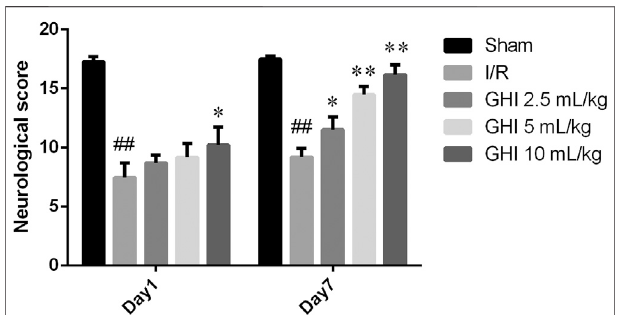
FIGURE 1 | Effect of GHI on neurological de fi cit scores in focal cerebral I/R rats. Groups were as follows: Sham group (Sham), ischemia-reperfusion group(I/Rgroup),GHI2.5 ml/kggroup,GHI5 ml/kggroup,andGHI10 ml/kg group at 1 and 7 days, respectively. Values were expressed as mean ± SD (n (cid:2) 8). ## p < 0.01 vs. the Sham group, * p < 0.05, ** p < 0.01 vs. the I/R group.